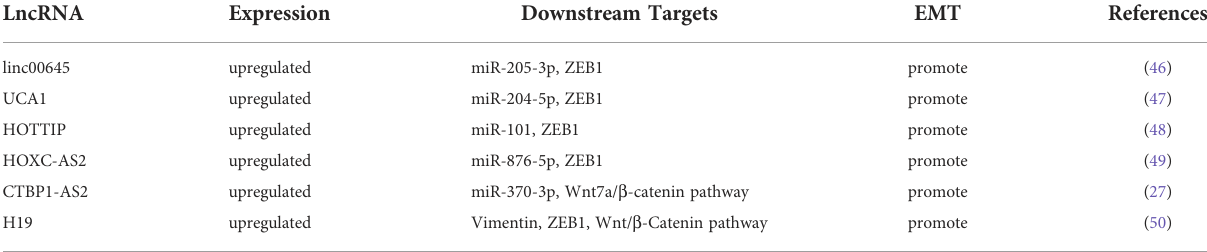
TABLE 3 Representative lncRNAs and related signaling pathways of EMT process in glioma.